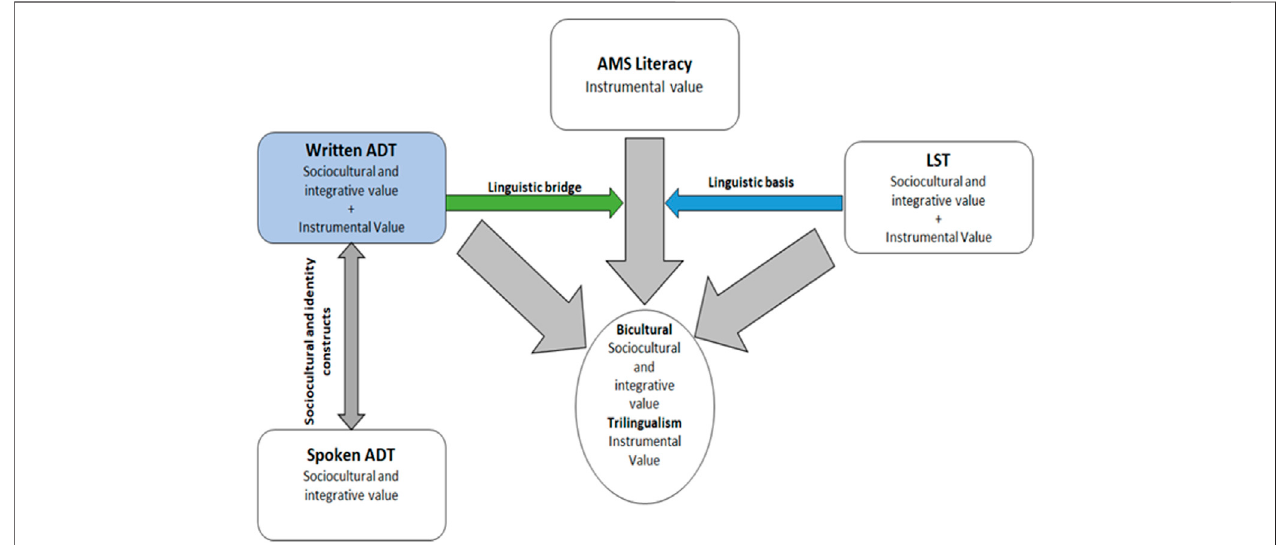
FIGURE 6 | The trilingual bicultural